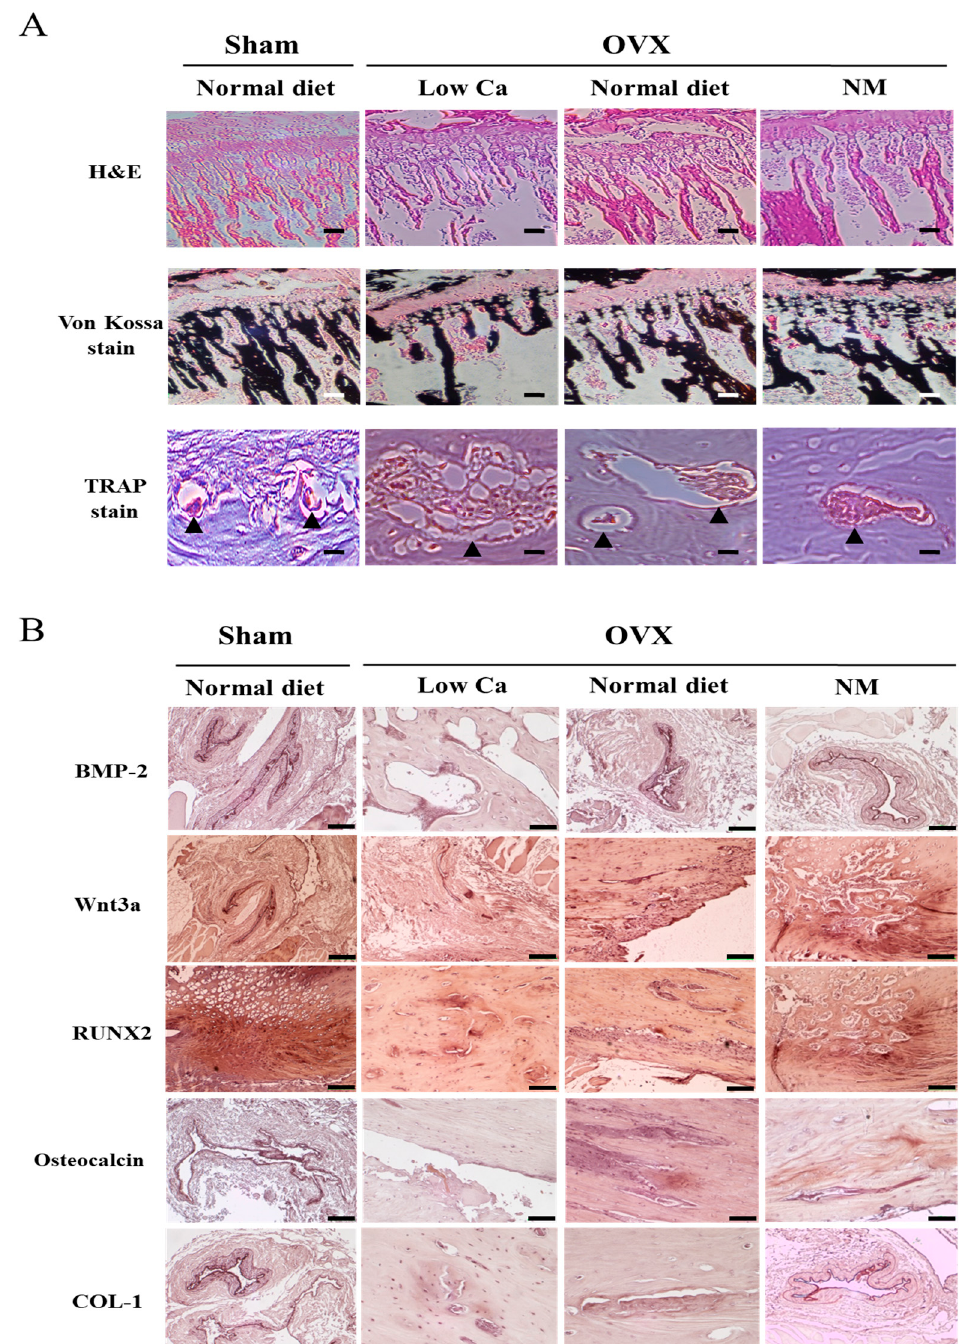
Figure 6. Histomorphology of the tibia of ovariectomized (OVX) rats. ( A ) Hematoxylin and Eosin (H&E) stain, von Kossa stain, and tartrate-resistant acid phosphatase (TRAP) stain of the tibia. Black triangles indicate osteoclasts. Scale bar: 20 µ m ( B ) Immunohistochemical staining image of bone morphogenetic protein-2 (BMP-2), Wnt family member 3a (Wnt3a), runt-related transcription factor-2 (RUNX2), osteocalcin, and type 1 collagen (COL-1) in OVX rats. Scale bar: 100 µ m. 3.11. NM Promotes in Vivo mRNA and Protein Expression of Genes Involved in